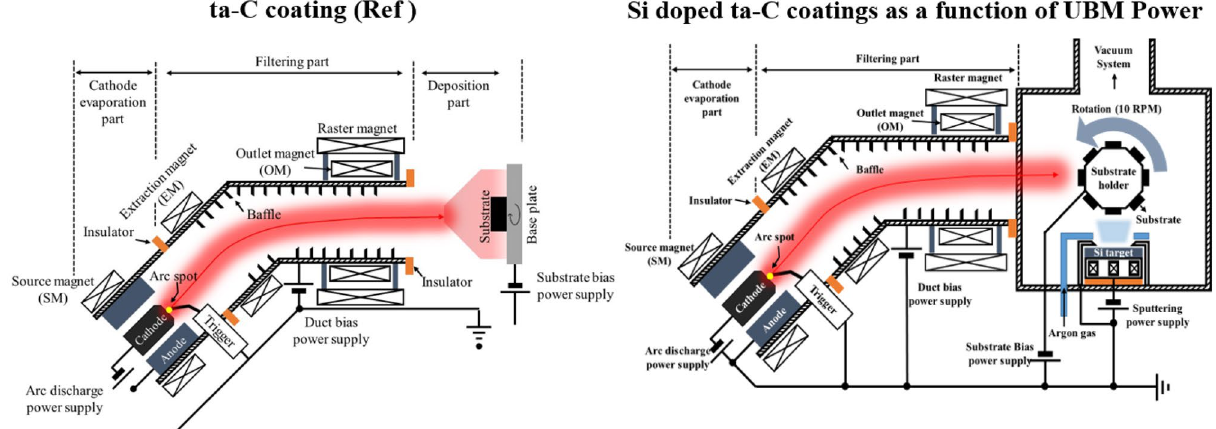
Figure 1. Schematic illustration of tetrahedral amorphous carbon (ta-C) and Si/SiC/ta-C composite (Si–ta-C) coating procedures using a filtered cathode vacuum arc (FCVA) and unbalanced magnetron (UBM) sputtering coating